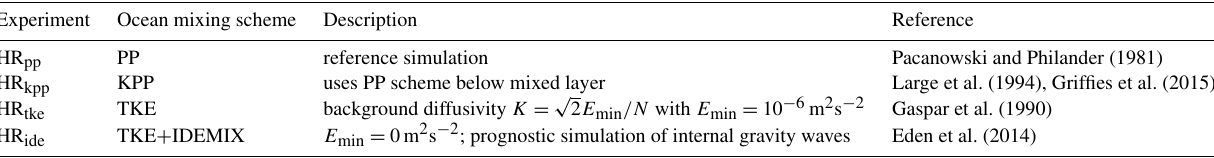
Table 1. Overview of the 100-year long control simulations conducted with MPI-ESM1.2-HR. All simulations use a T127 (about 100km) resolution in the atmosphere and a resolution of 0.4 ◦ (about 40km) on a tripolar grid (TP04) in the ocean. The number of vertical levels is 95 in the atmosphere and 40 in the ocean, respectively. All models were analysed for model years